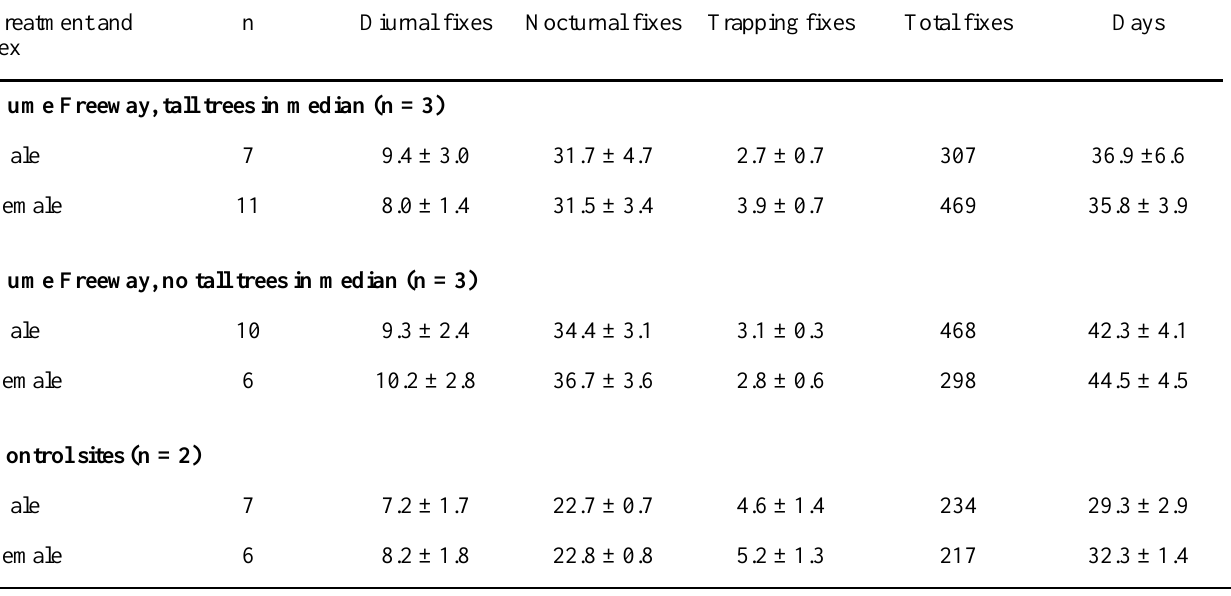
Table 1. Summary of survey effort for 47 squirrel gliders ( Petaurus norfolcensis ) tracked along the Hume Freeway and at control sites, southeastern Australia from October 2005 to December 2006. n, number of individuals; fixes are number of detections from radio-tracking during the day (diurnal) or night (nocturnal) or from trapping; days, mean number of days on which fixes were obtained. Values are means ± 1 SE.